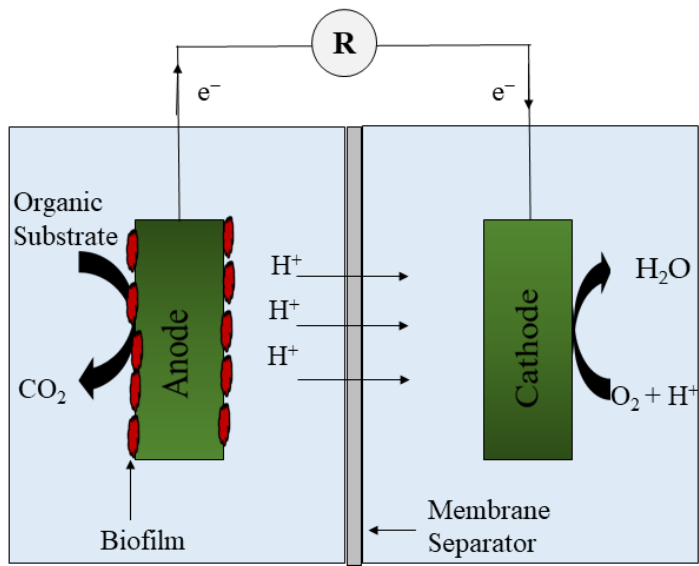
Figure 1. A typical stand-alone microbial fuel cell.